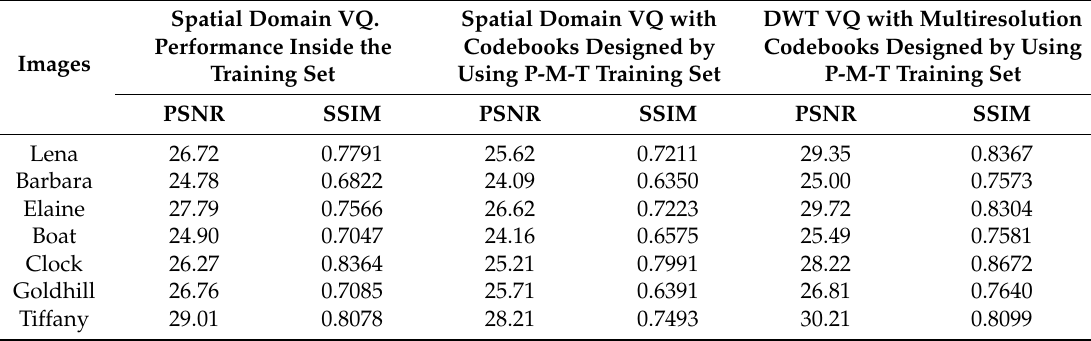
Table 15. PSNR (in dB) and SSIM of reconstructed images. Codebooks were designed using MFKM2-ENNS in spatial domain as well as by the DWT domain for code rate 0.3125 bpp. DWT VQ with Multiresolution Spatial Domain VQ with Spatial Domain VQ. Codebooks Designed by Using Codebooks Designed by Performance Inside the Images P-M-T Training Using P-M-T Training Set Training Set